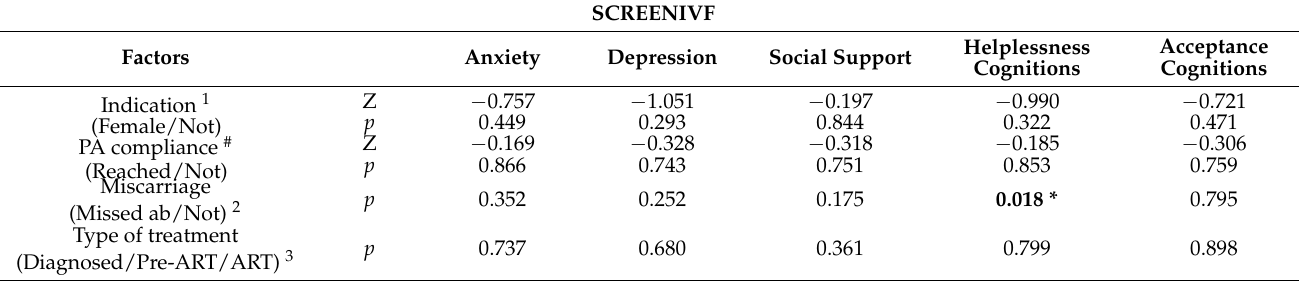
Table 6. Difference between dimensions of psychological maladjustment based on the Hungarian version of SCREENIVF and factors with possible psychological